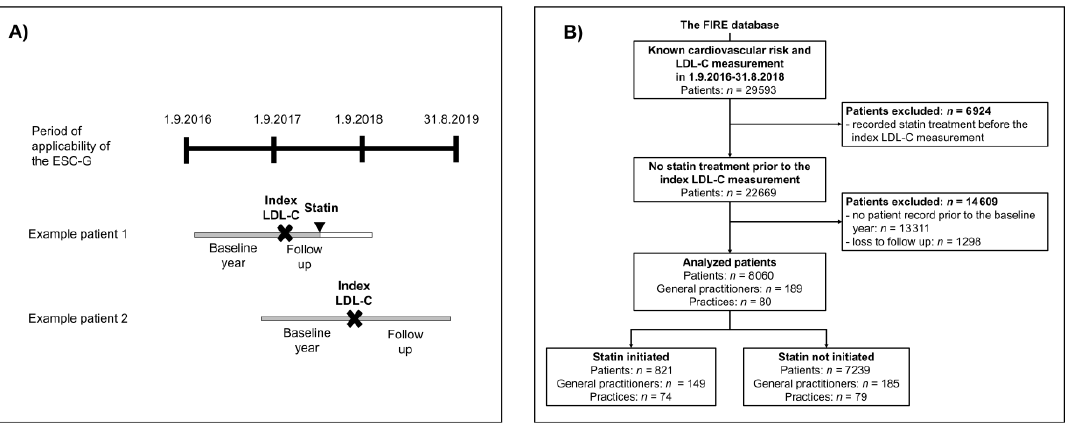
Figure 1. Study phases and participants. ( A ) Graphical representation of study phases for two example patients. Patient 1 was initiated on a statin; patient 2 was not initiated on a statin. The grey bar represents their individual observation period (covering baseline year and follow up). ( B ) Flowchart of the patient selection process. Abbreviations: ESC-G, 2016 European Society of